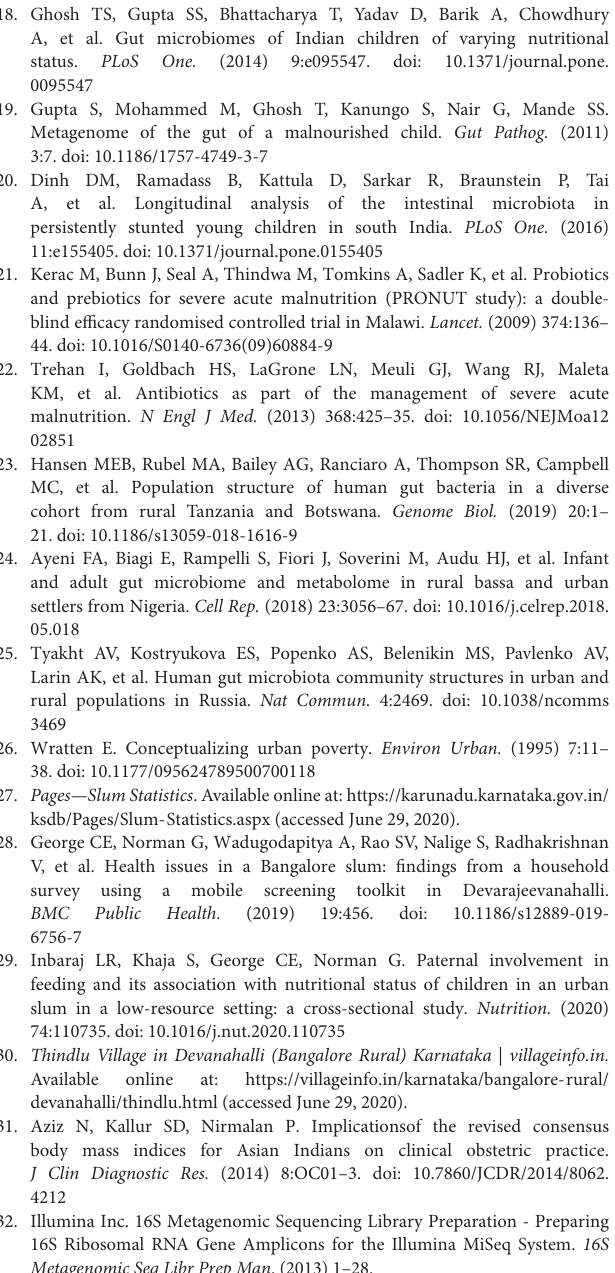
undernourished and nourished from rural and urban slum settings, and (C) Across the location (rural and urban slum). Supplementary Figure 2 | Box and Whisker plot depicting Beta Diversity (unweighted Unifrac distances) based on location. p -values indicate independent t -tests statistical significance categorizing the study groups based on the location (i.e rural vs urban slum). Box-and-whisker plots show high, low, and median values, with lower and upper edges of each box denoting first and third quartiles, respectively. ns indicates non-significant p -values. Black dots represent the outliers.